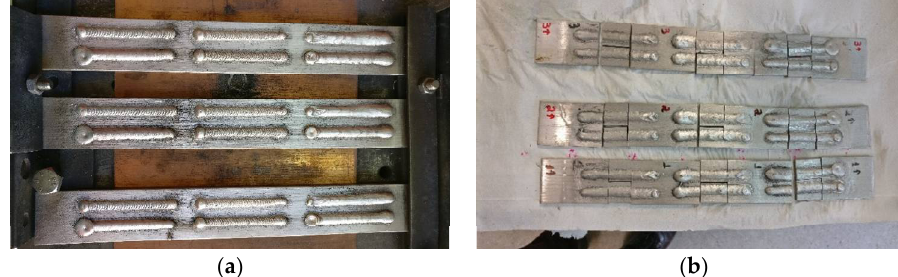
Figure 2. Aluminum specimens: ( a ) welding samples; ( b ) cut welding samples.